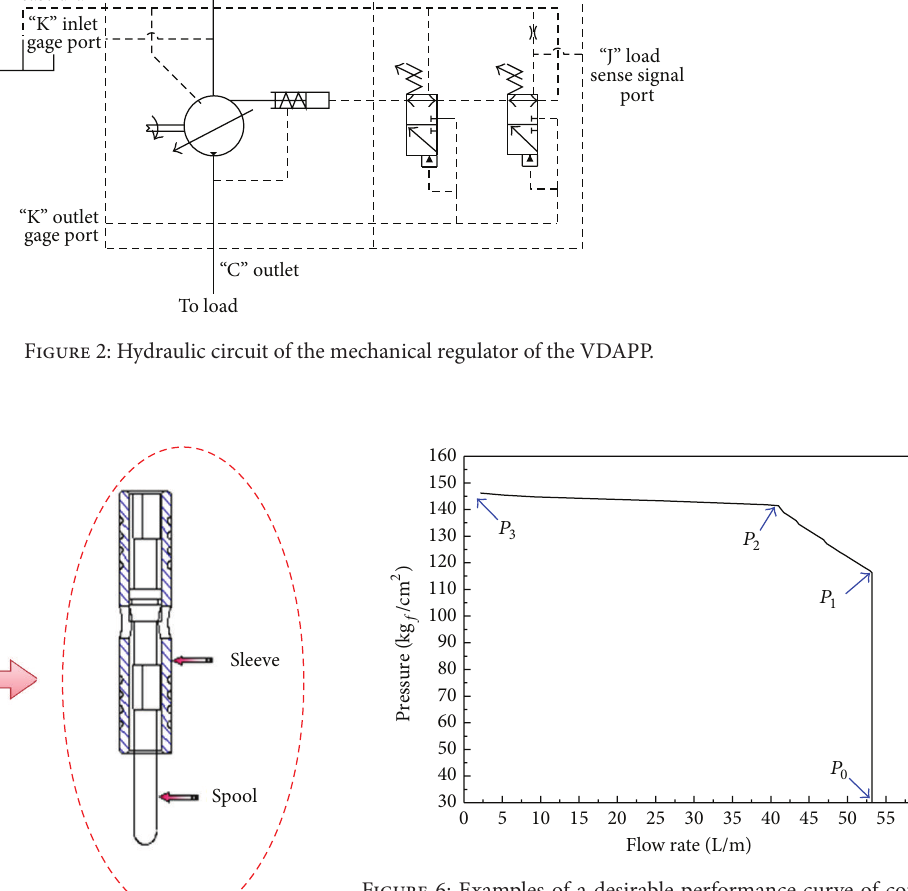
Figure 6: Examples of a desirable performance curve of constant power regulator